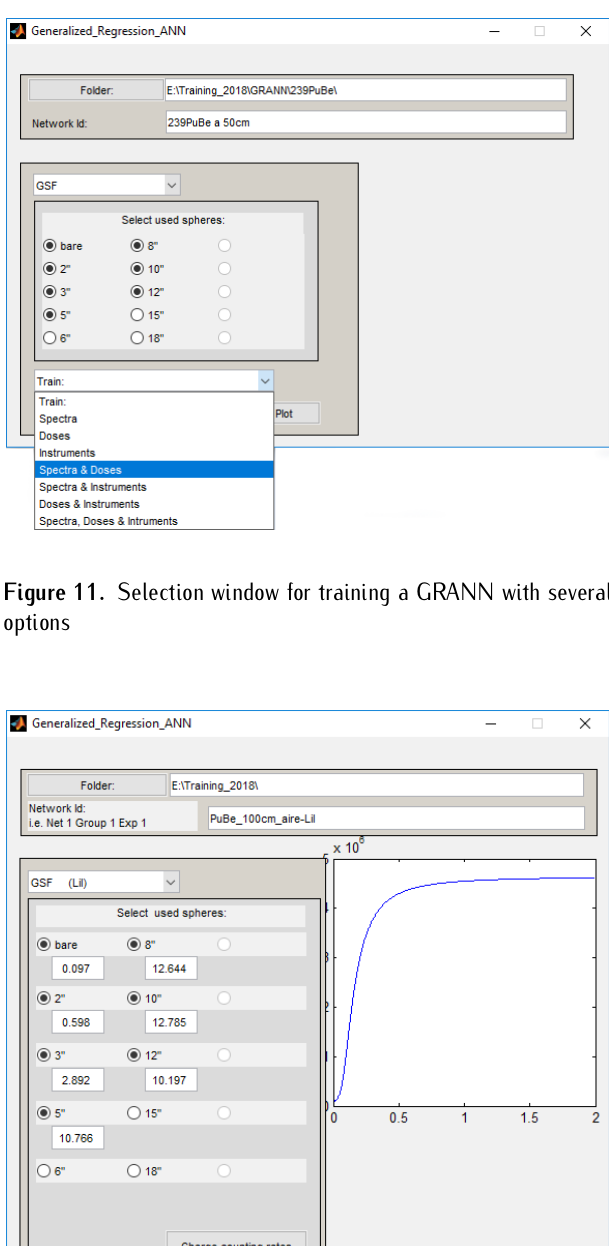
unfolded spectrum of both, a 239 P uBe and a 252 Cf neutron sources were calculated and compared with the reference neutron sources taken from the IAEA